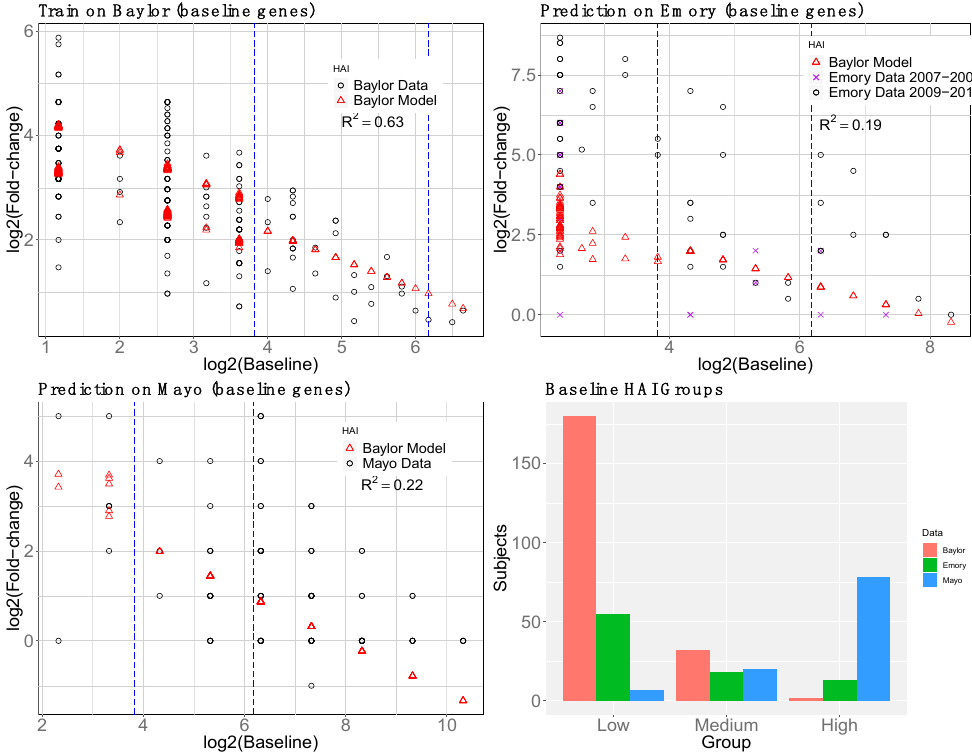
Figure 6. Non-reGAIN filtering used in the second-stage (gene) model prediction of post-vaccine HAI. Same as Figure 5 but instead of reGAIN feature selection, coefficient of variation was used to filter genes. The R 2 for non-reGAIN is lower than reGAIN for training and testing. 319